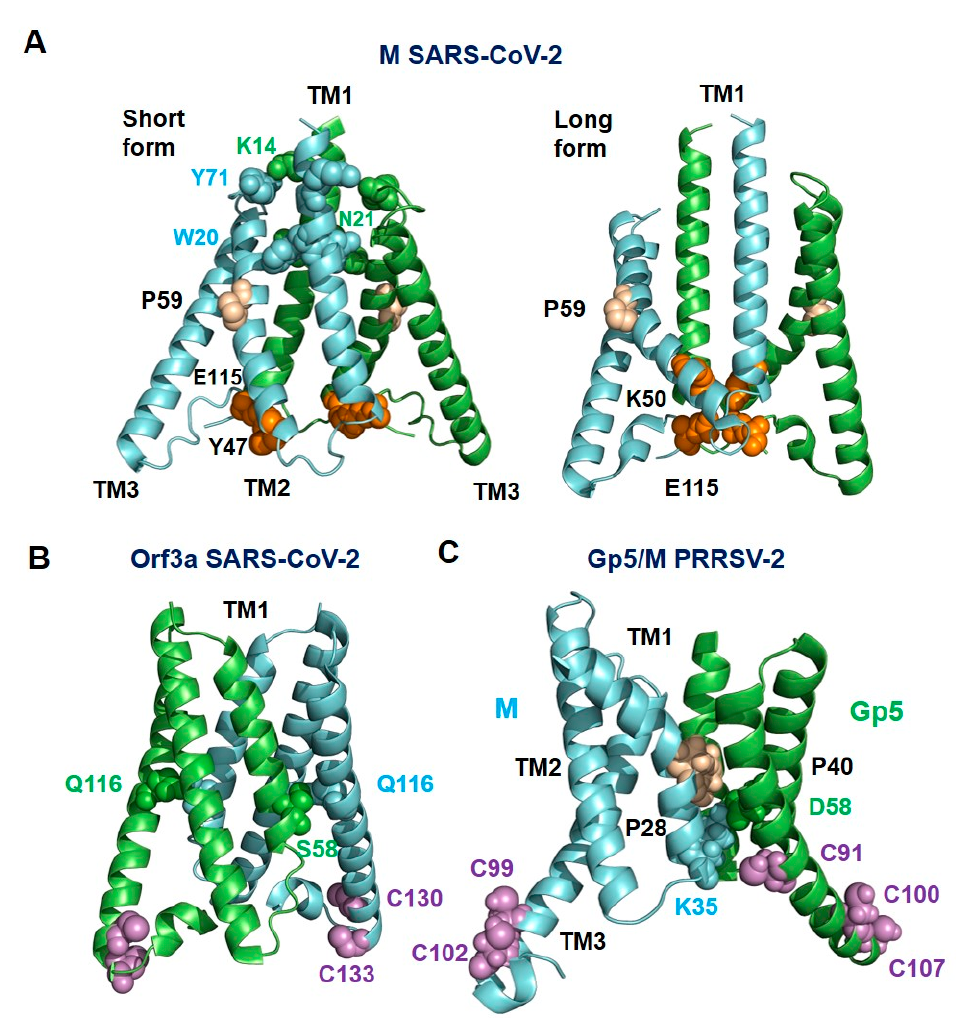
Figure 8. Structure of the transmembrane region of the short and long form of M ( A ), Orf3a ( B ) of SARS-CoV-2 and Gp5/M of PRRSV-2 ( C ). ( A ). One monomer of Orf3a and M of SARS-CoV-2 is colored green, and the other is colored cyan. Gp5 is colored green and M is colored cyan in the predicted structure of Gp5/M of the PRRSV-2 reference strain VR 2332. Proline residues in TM2 of M of SARS-CoV-2 and TM1 of Gp5/M are highlighted as wheat spheres, and cysteine residues at the C-terminus of TM3 of Gp5/M and Orf3a are highlighted as magenta spheres. Residues that form hydrophilic interactions between the monomers are highlighted as spheres with the color of the respective monomer. Residues forming interactions between the hinge region and TM2 in the short and long form of M of SARS-CoV-2 are highlighted as orange spheres. Figures were created with Pymol from PDB-file 7VGS (M, short form), 7VGR (M. long form) and 6XDC (Orf3a).